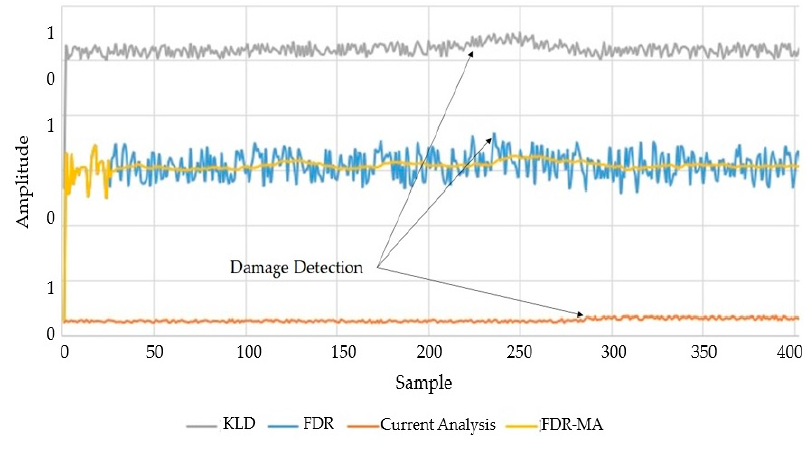
Figure 5. Early bearing damage detection caused by wear.